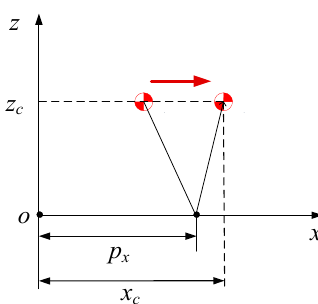
Figure 14. A linear inverted pendulum represented in the ground fixed frame.